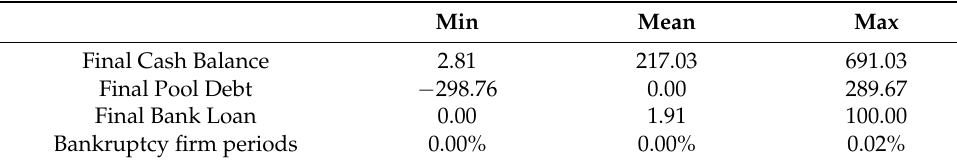
Table 4. Results for the base case with